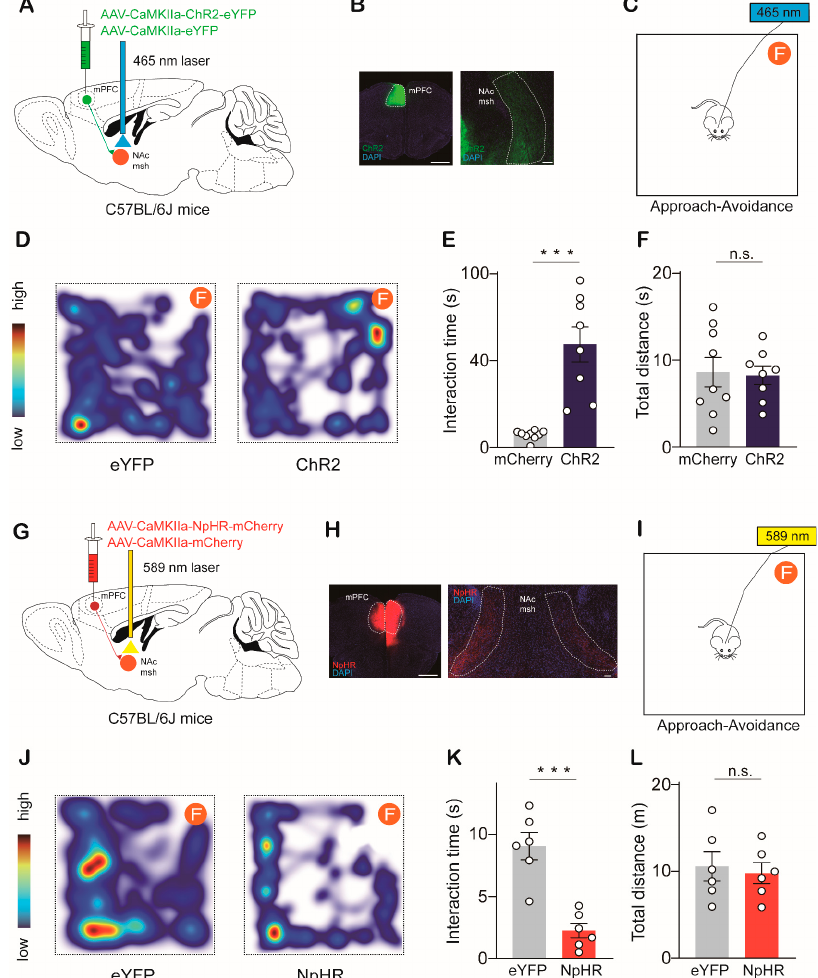
Figure 5. The mPFC Glut inputs to NAc modulate aversive behaviors in mice ( A ) Schematic showing unilateral optogenetic stimulation of mPFC Glut inputs to NAc msh by ChR2. ( B ) Representative images of injection and projection sites. Scale bar: 1 mm and 100 µ m, respectively. ( C ) Schematic of approach-avoidance assay (F: form, 5% formaldehyde solution). ( D ) Heat maps displaying time spent in different regions of the chamber (warmer colors indicate more time). ( E ) Mice expressing ChR2, but not mCherry, spent significantly more time interacting with formaldehyde with 20 Hz optical stimulation (two-tailed paired t -test, t 15 = 5.451, p < 0.0001). ( F ) Mean total distance traveled in the chamber (two-tailed paired t -test, t 15 = 0.1827, p = 0.8575). eYFP: N = 9; ChR2: N = 8. ( G ) Schematic showing bilateral optogenetic inhibition of mPFC Glut inputs to NAc msh by NpHR. ( H ) Representative images of injection and projection sites. Scale bar: 1 mm and 100 µ m, respectively. ( I ) Schematic of approach-avoidance assay (F: form, 5% formaldehyde solution). ( J ) Heat maps displaying time spent in different regions of the chamber (warmer colors indicate more time). ( K ) Mice expressing NpHR, but not eYFP, spent significantly less time interacting with formaldehyde with continuous optical stimulation (two-tailed paired t -test, t10 = 5.493, p = 0.0003). ( L ) Mean total distance traveled in the chamber (two-tailed paired t -test, t10 = 0.3778, p = 0.7135). eYFP: N = 6; NpHR: N = 6. N: animal number. mPFC: medial prefrontal cortex; NAc msh: nucleus accumbens medial shell. All data are means ± s.e.m. *** p < 0.001; n.s.: not